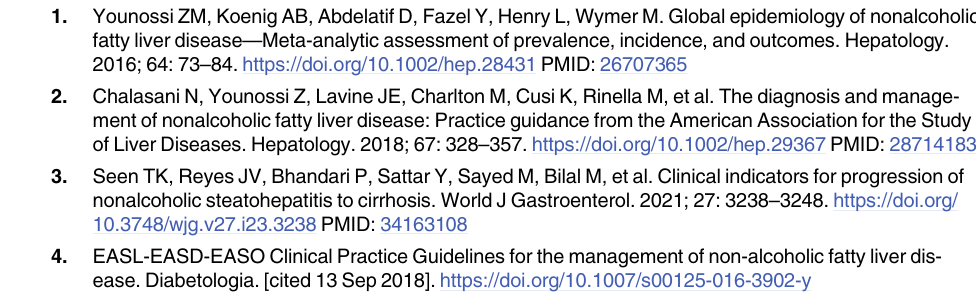
S1 Table. Additional anthropometrical and biochemical characteristics of study partici- pants divided into three groups with increasing NAFLD activity score. Data are presented as median with interquartile range in parentheses unless otherwise stated. P values are Krus- kal-Wallis tests. � p < 0.05; �� p < 0.01 (Dunn’s post-hoc test, compared to NAS 0–1) Abbrevia- tions: NAFLD, non-alcoholic fatty liver disease; NAS, NAFLD activity score; AUDIT-C, alcohol use disorders identification